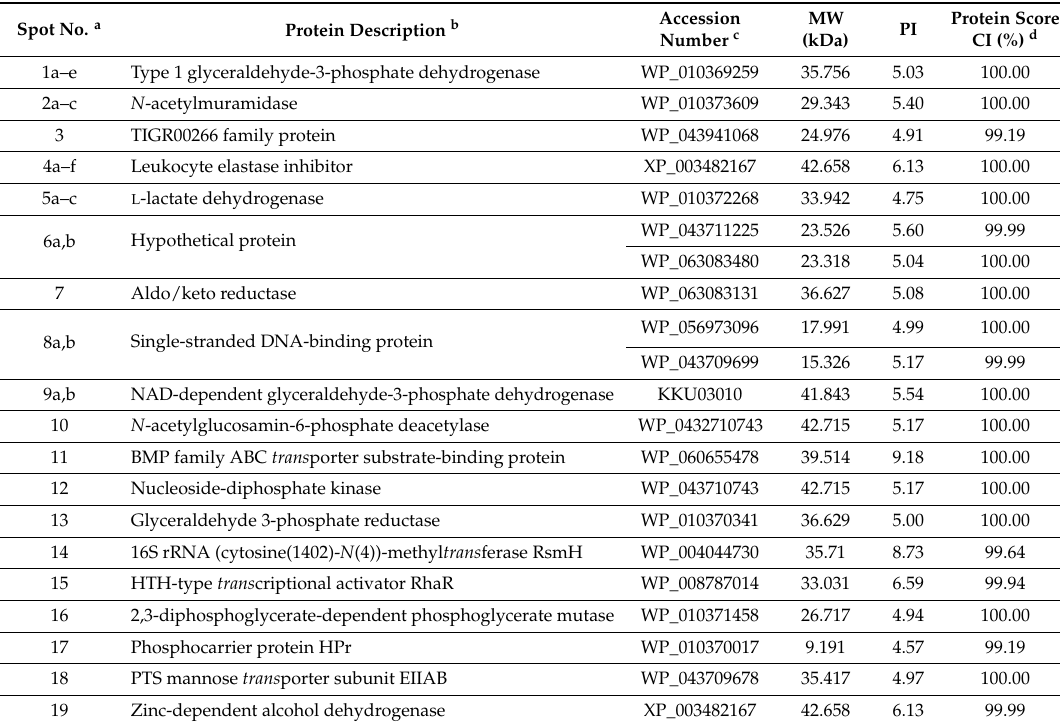
Figure 4. 2D-gel electrophoresis of secreted proteins in the CFS of oraCMU after 16 h incubation at 37 °C. Table 2. Secreted proteins identified in the CFS of oraCMU.